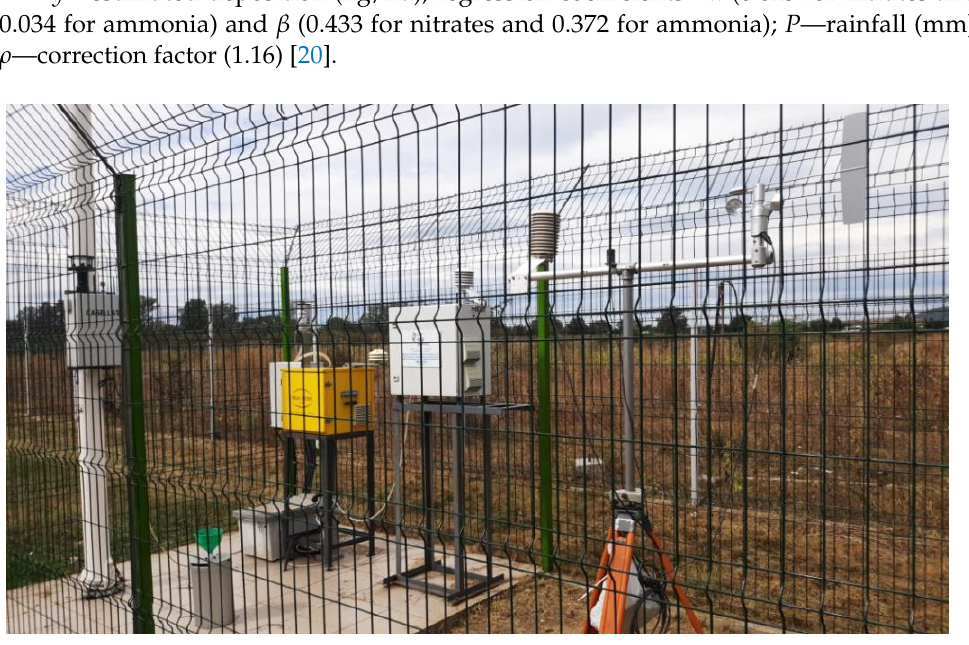
Figure A1. Instruments used in the northern monitoring platform (from left to right): Casella Guardian 2 (PM 10-2.5-1 monitoring), PALMEX RS1 B (rain sampler), Mega-System LVS Select One (PM gravimetric sampler), Rokidair Optical Monitor (PM monitoring), and a Delta-T Devices weather station.